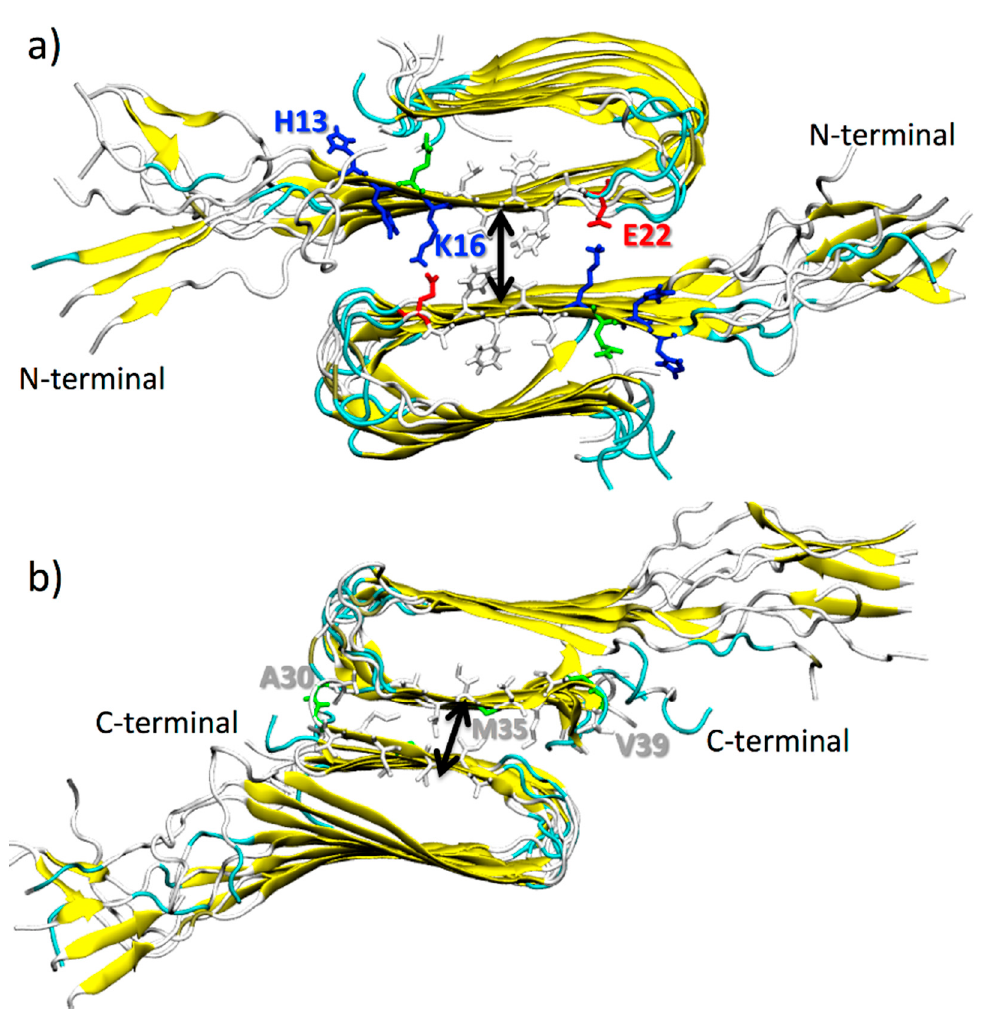
Figure 1. Cartoon representation of double-layered structures of A β (1–40) oligomers facing through their β -1, in ( a ), and β -2 β -sheets, in ( b ). Fibrils are colored according to their secondary structures. Amino acids at the interface are explicitly represented (color code: blue for positively charged, red for negatively charged, and white for hydrophobic amino acid residues). Black arrows roughly represent the intersheet distance.